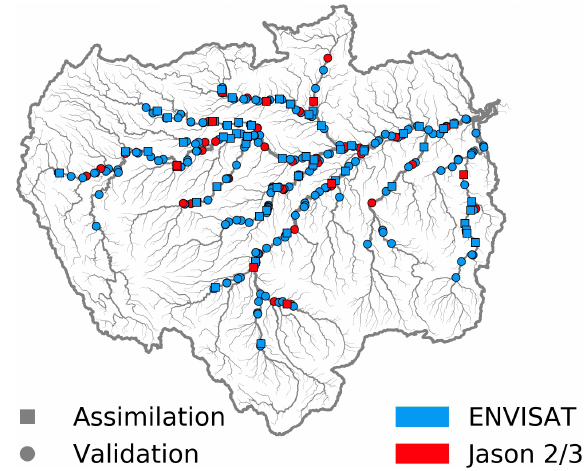
Figure 3. Spatial distribution of the satellite virtual stations (VSs) used in this study. ENVISAT VSs are shown in red, and Jason 1 and Jason 2 VSs are in blue. VSs used for assimilation and validation are indicated with squares and circles,